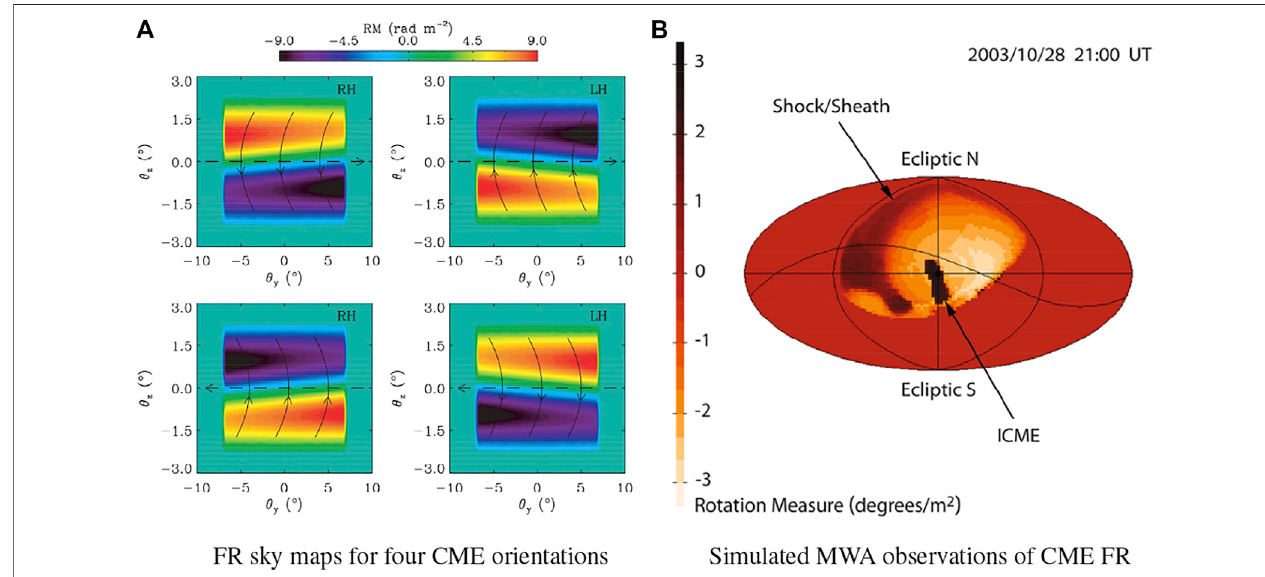
FIGURE4| SimulatedskymapsofFRfordifferentmagnetic fl uxropecon fi gurations.In (A) ,foragivengeometricorientationwithrespecttotheLOS,therearefour possiblecon fi gurationsfortheaxialmagnetic fi eld(dashedarrow)andhelicity(solidcurvedlines),whichgeneratearangeofFaradayrotationmeasure(RM)values.Panel (B) shows the expected FR for a CME on 2003 October 28 as seen by the MWA. Both simulations demonstrate the powerful potential for FR observations to probe the magnetic structure of CMEs given many LOS are available. Left image appears as Figure 6 in Liu et al. (2007), ©AAS, reproduced with permission. Right